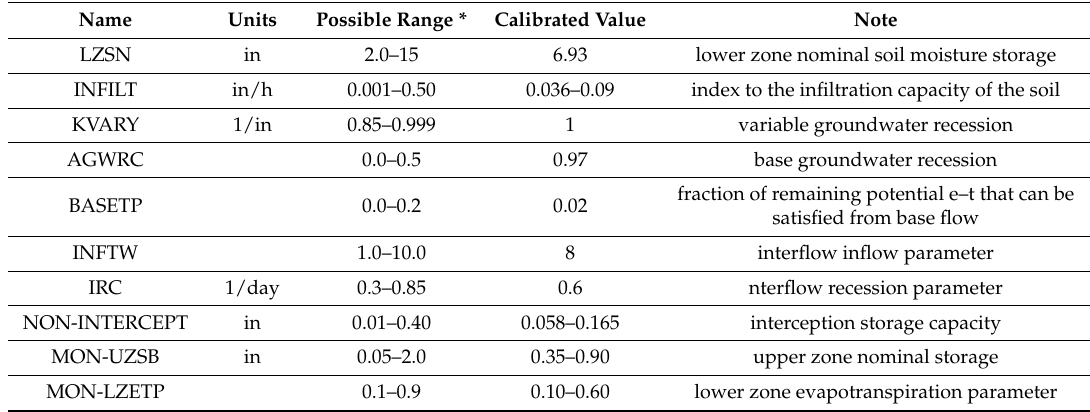
Table 2. Key parameters used for hydrological